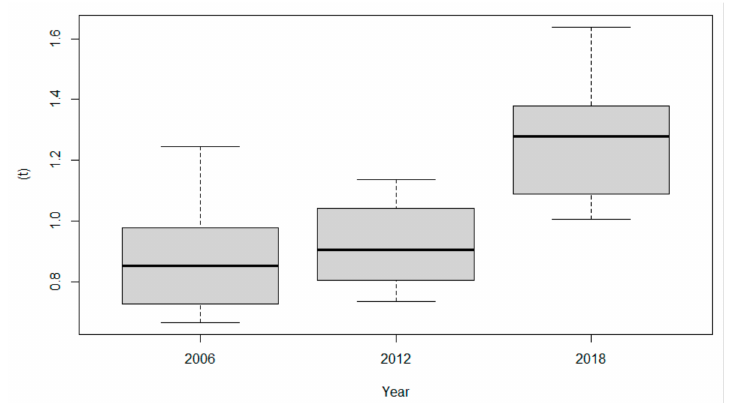
Figure 2. Development of communal waste per household.